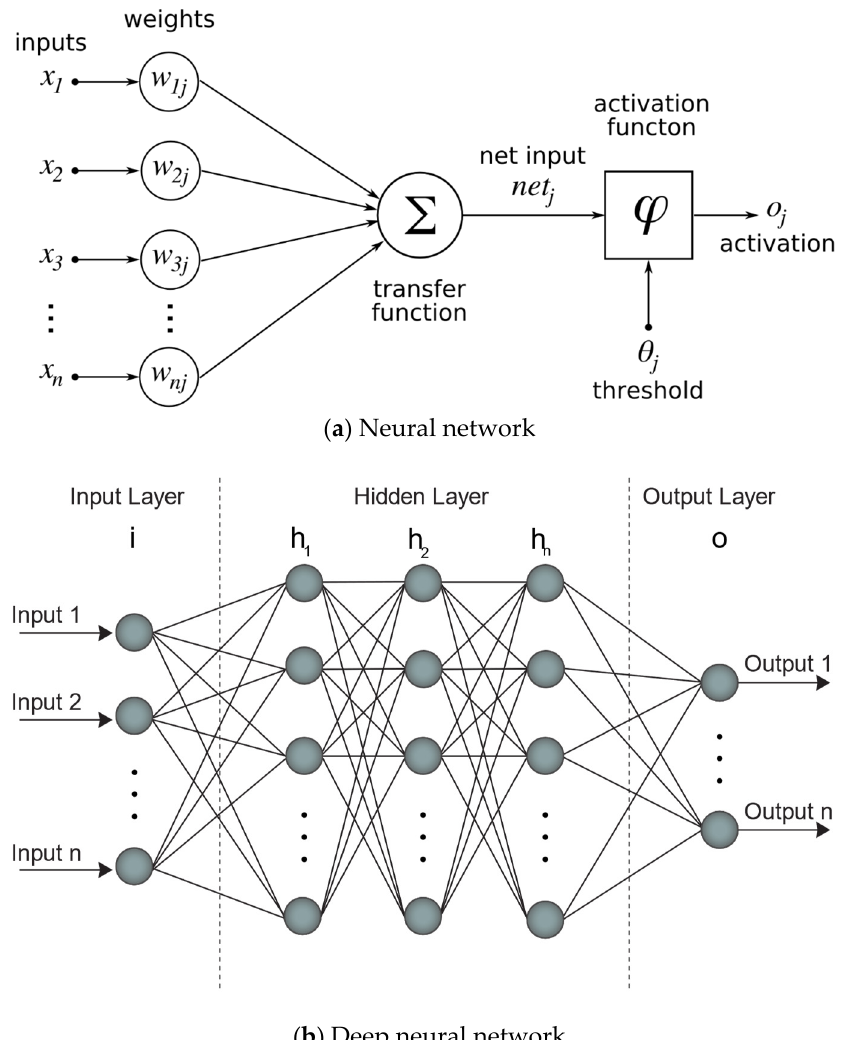
Figure 1. Illustration of a neural network with a large number of interconnected neurons. A neuron in the upper portion represents the concept of an artificial neural network.